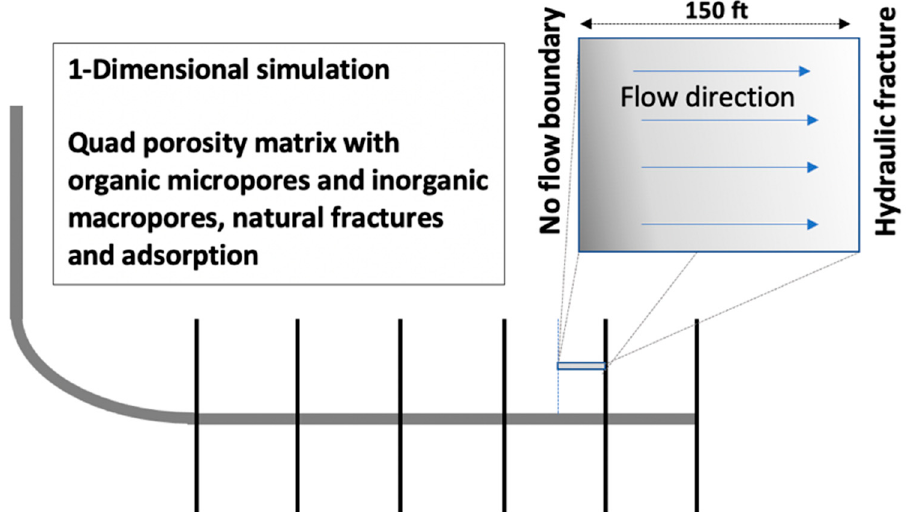
Figure 2. Schematic of the numerical model that was solved.